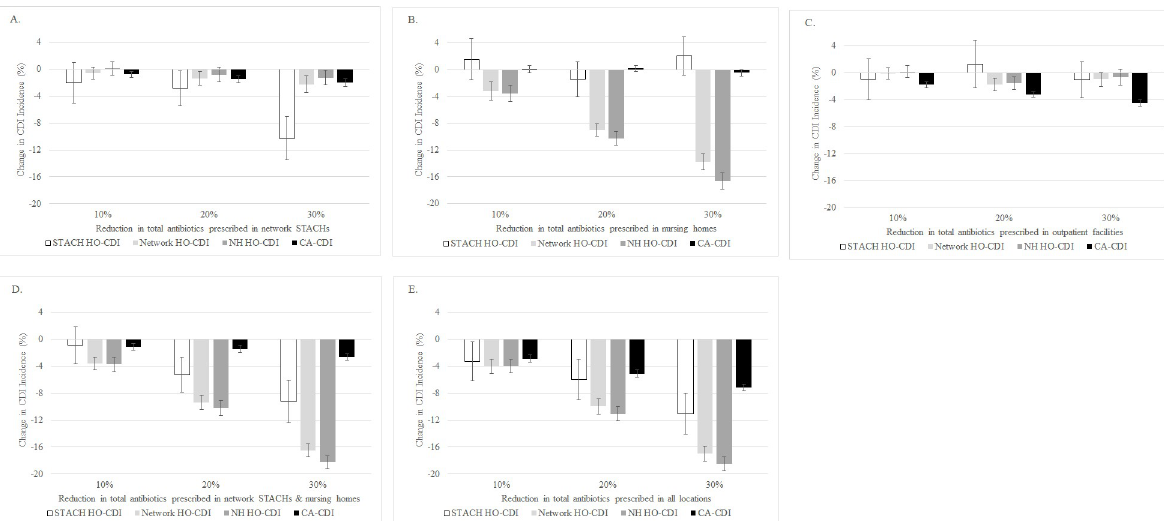
Fig 2. Clostridioides difficile infection (CDI) incidence and reductions in total number of antibiotics prescribed. Scenarios for reduction in total number of antibiotics prescribed are as follows: (A) at network STACHs only; (B) at nursing homes only; (C) at outpatient facilities only; (D) at all network STACHs and nursing homes; and (E) at all network inpatient (i.e., STACHs, nursing homes, LTACHs) and outpatient facilities. For each scenario, the total antibiotics prescribed were reduced by 10%, 20%, and 30%. Results are based on 40 runs for each scenario. Error bars indicate 95% confidence intervals on the percent change. (STACH: short-term acute care hospital; LTACH: long-term acute care hospital; HO-CDI: hospital (healthcare) onset-CDI; CA-CDI: community associated-CDI).